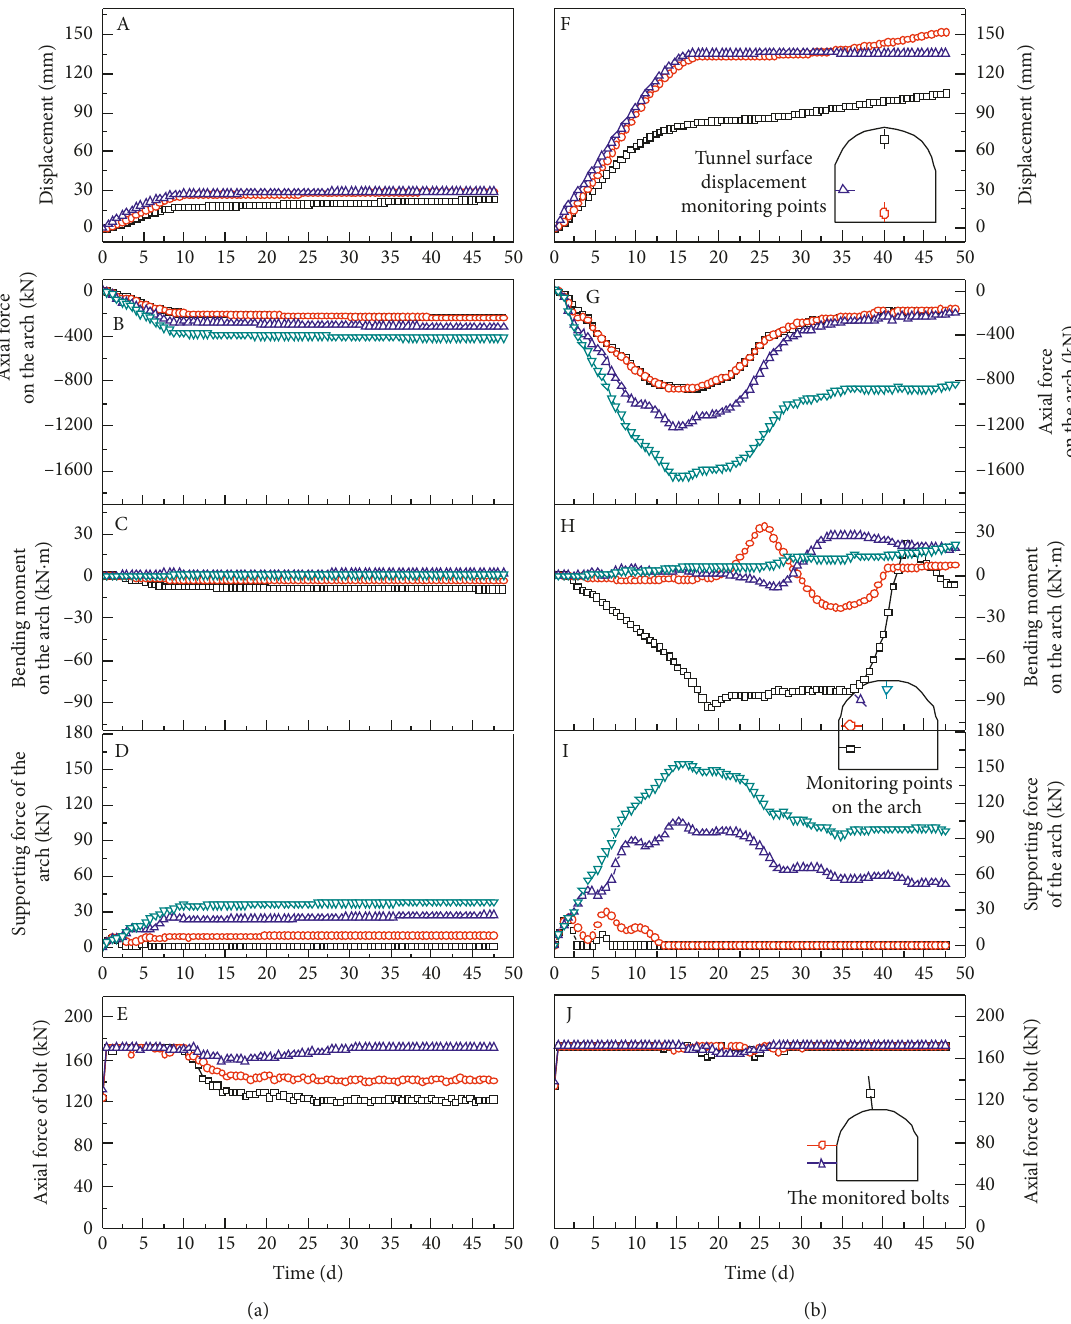
Figure 4: Evolution curves of Scheme 2 (ground stress 5MPa) and Scheme 3 (ground stress 10MPa). (A) ∼ (E): Evolution curves of roadway displacement, arch axial force, arch bending moment, arch supporting force, and rock bolt axial force of Scheme 2, respectively; (F) ∼ (J): Evolution curves of roadway displacement, arch axial force, arch bending moment, arch supporting force, and rock bolt axial force of Scheme 3, respectively. (a) Scheme 2 (5MPa). (b) Scheme 3